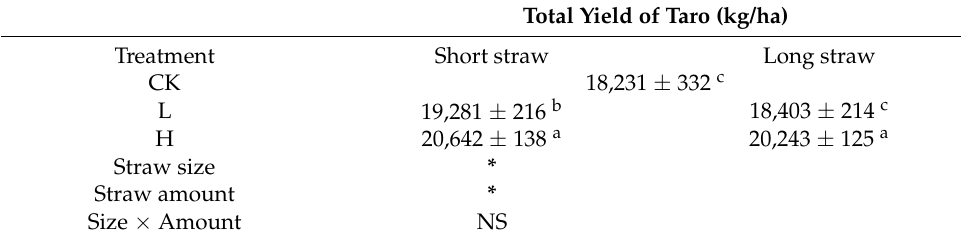
Table 2. Changes in the total taro yields under different wheat straw mulching